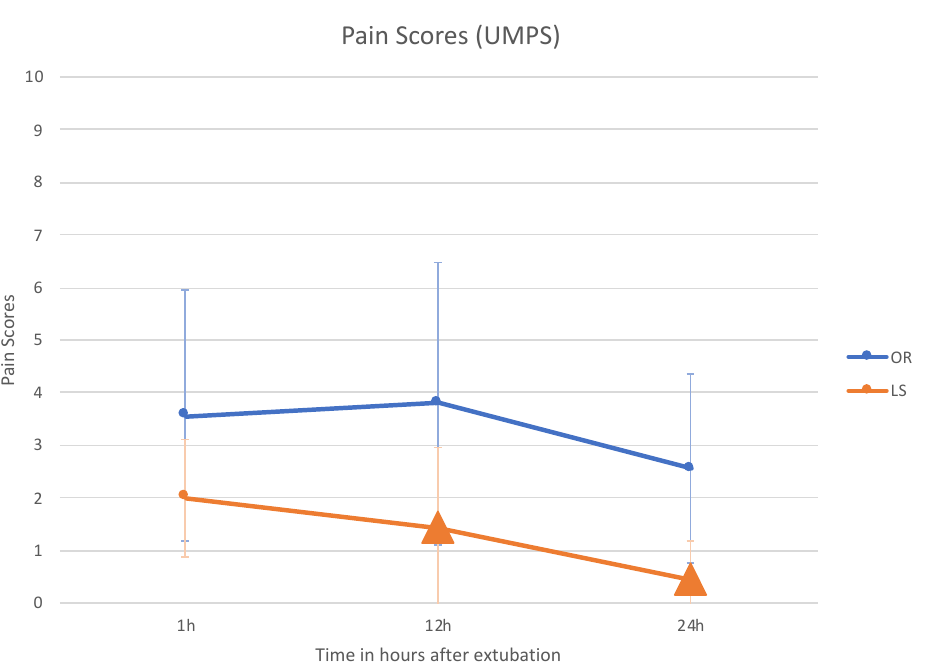
Figure 6. University of Melbourne Pain Scale post-operative scores in groups OR and LS (triangles show the significant values). Table 3. UMPS Scores (mean + SD) of dogs that underwent orchiectomy and laparoscopic sterilization.